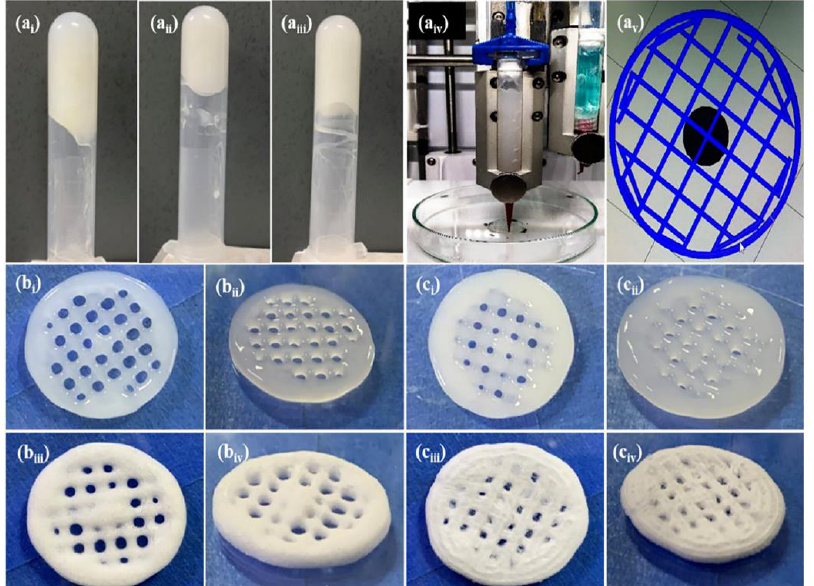
Figure 21. Digital images of TCNF gel 1.25 wt.% ( a i ), 1.75 wt.% ( a ii ), and TCNF/casein conjugate